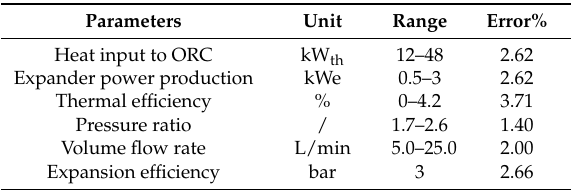
Table 1. Accuracy of calculated parameters